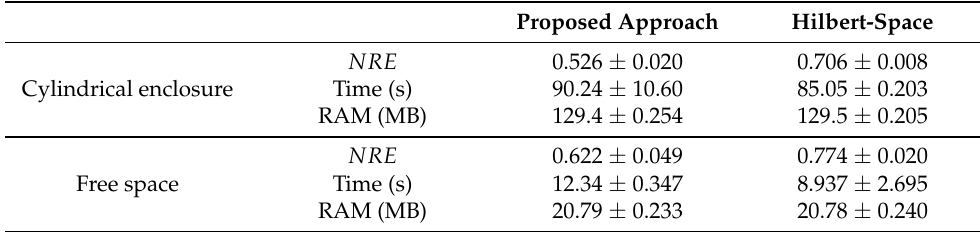
Table 2. Rectangular cylinder. Reconstruction errors ( NRE ), computational times (mean value ± stan- dard deviation) and required random access memory (RAM) with the proposed L p -space approach compared with a Hilbert-space formulation. Proposed Approach